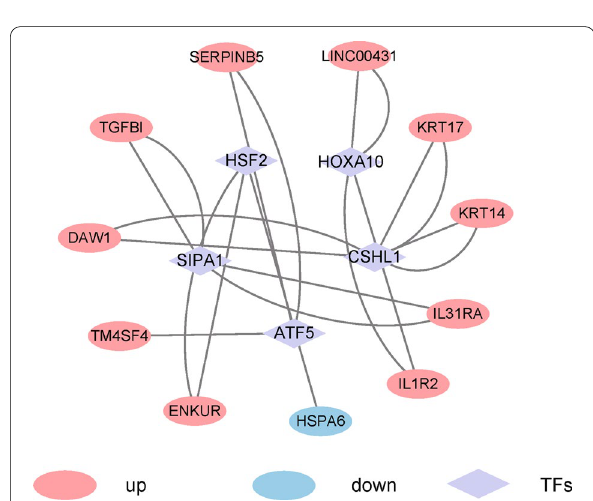
Fig. 12 The mRNAs–lncRNA–TFs regulatory